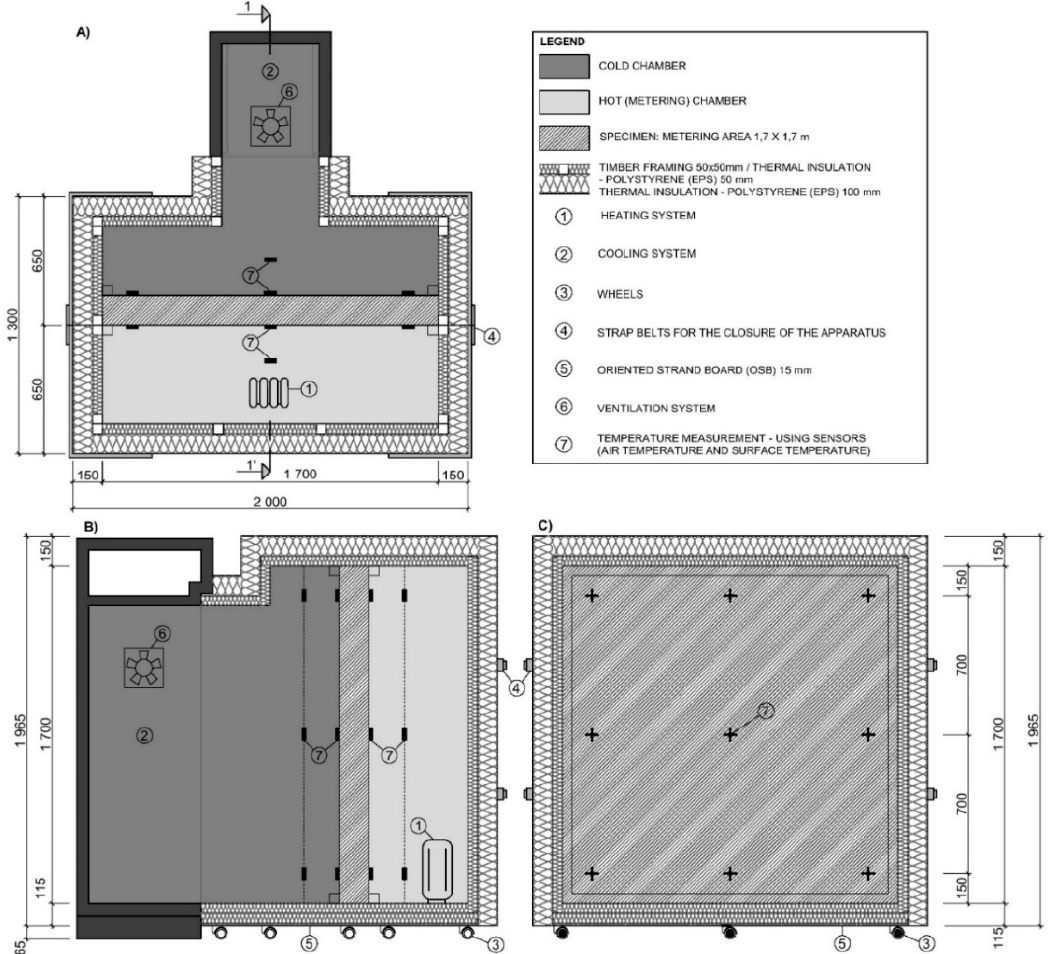
Figure 5. Modified guarded hot box design: ( A ) hot box horizontal section; ( B ) hot box vertical section 1-1’; ( C ) frontal view from the hot/cold side .